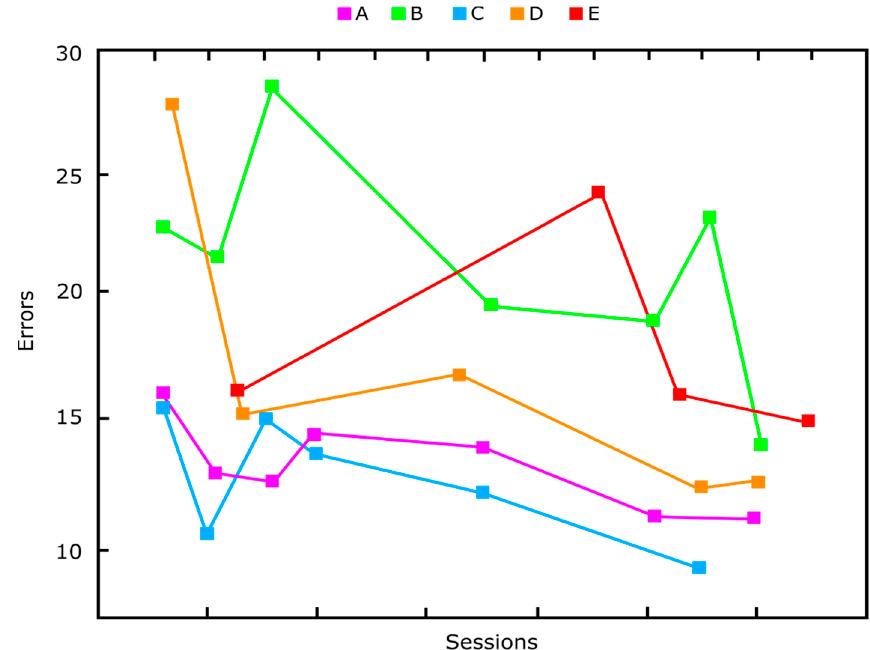
Figure 10. Progress of “guess the movements” exercise.